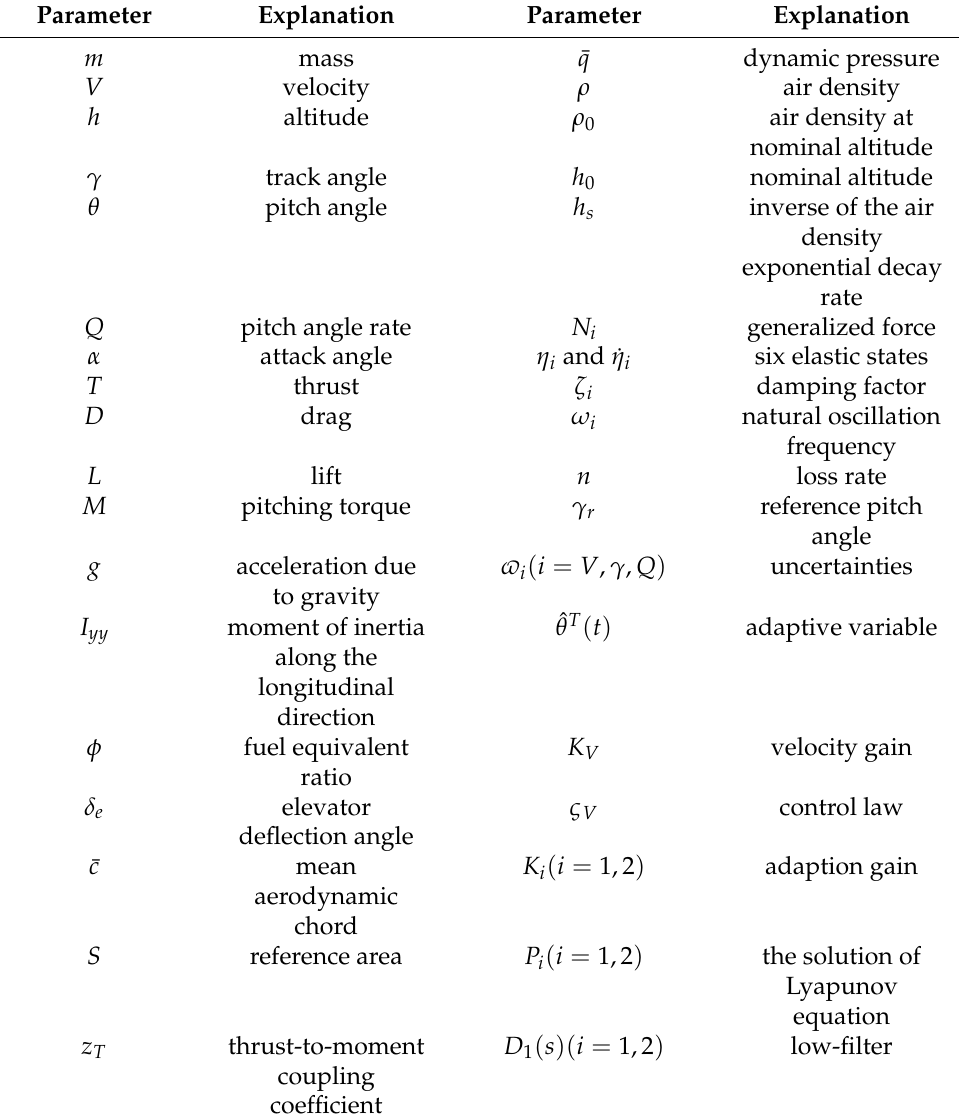
Table 1. Explanation of